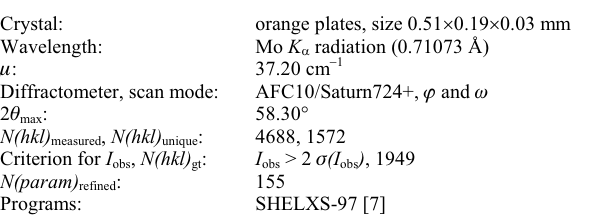
Table 1. Data collection and handling.